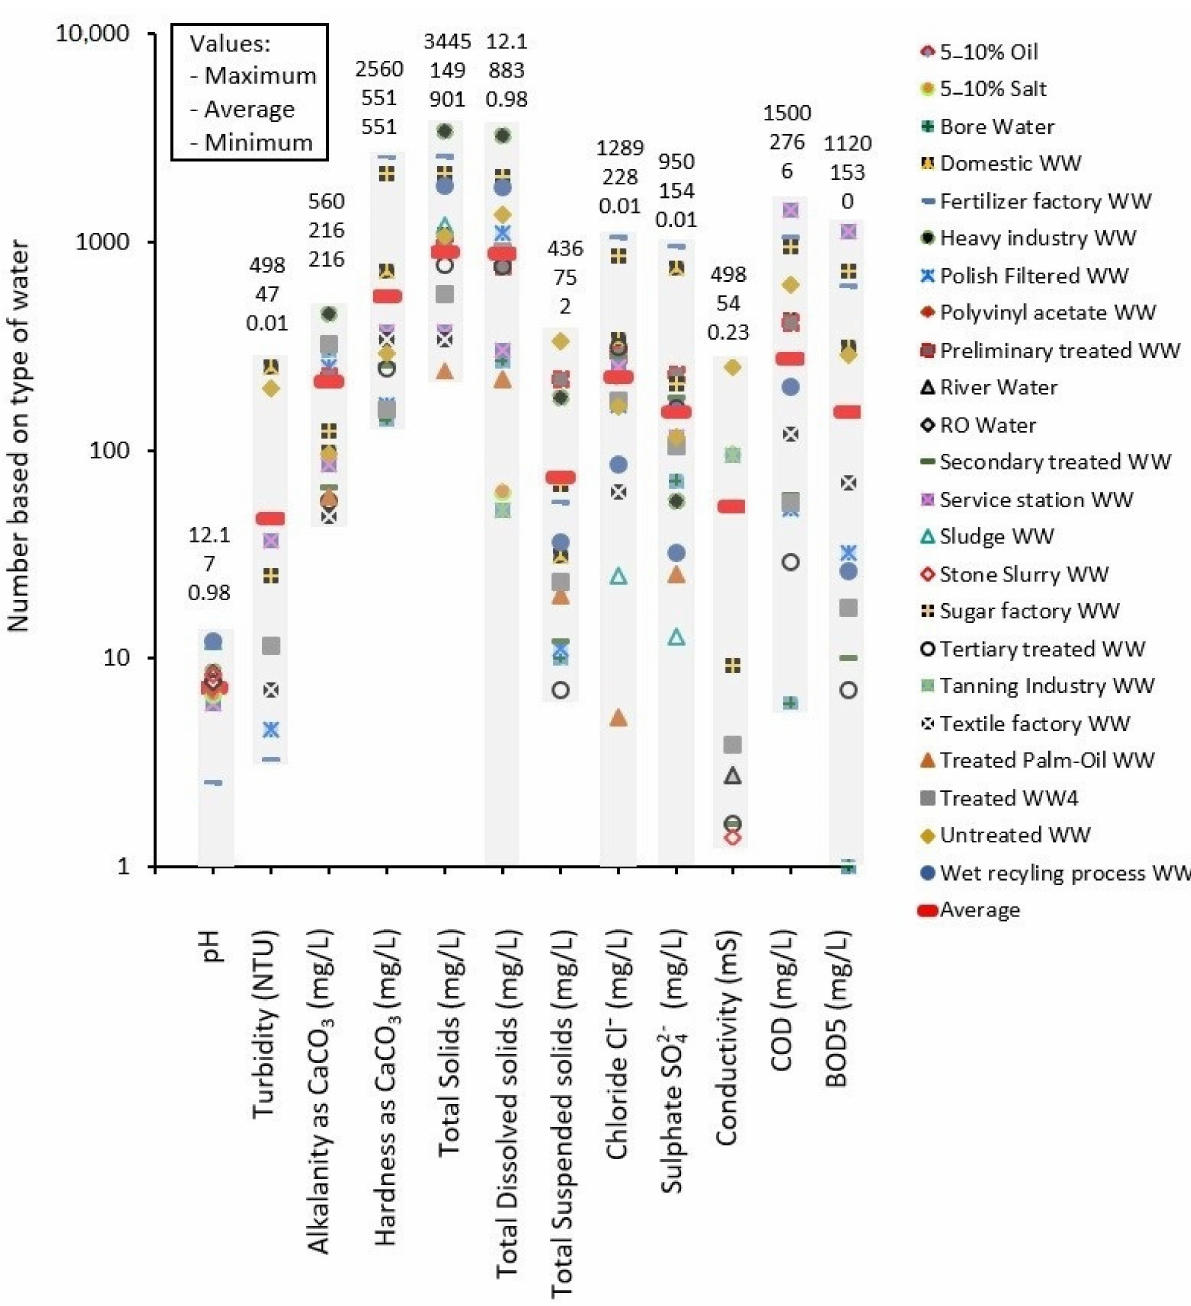
Figure 1. Average chemical and physical properties of non-conventional mixing